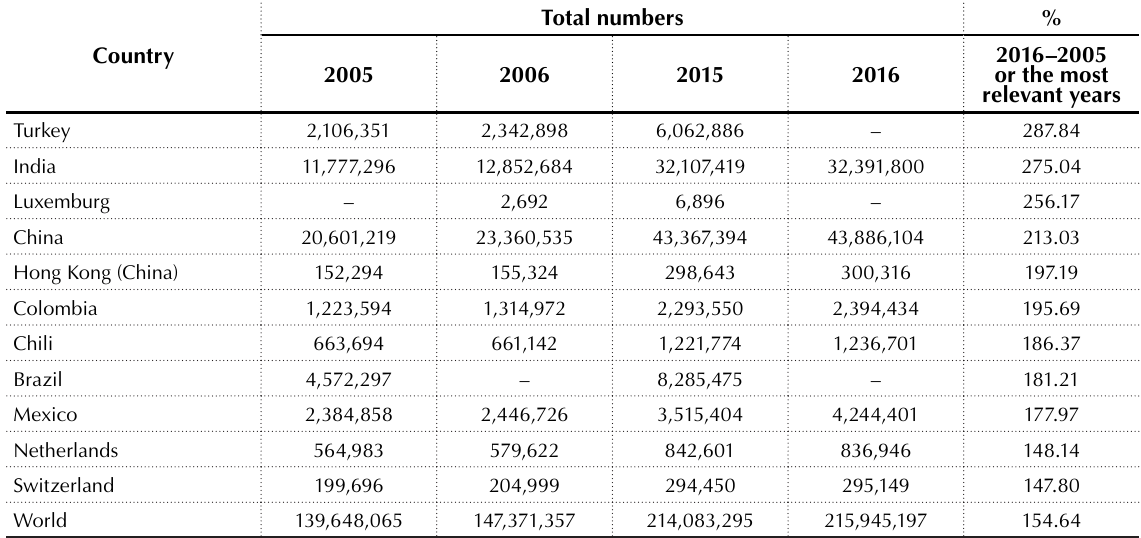
Table 1. TOP-10 countries by increase in number of students,